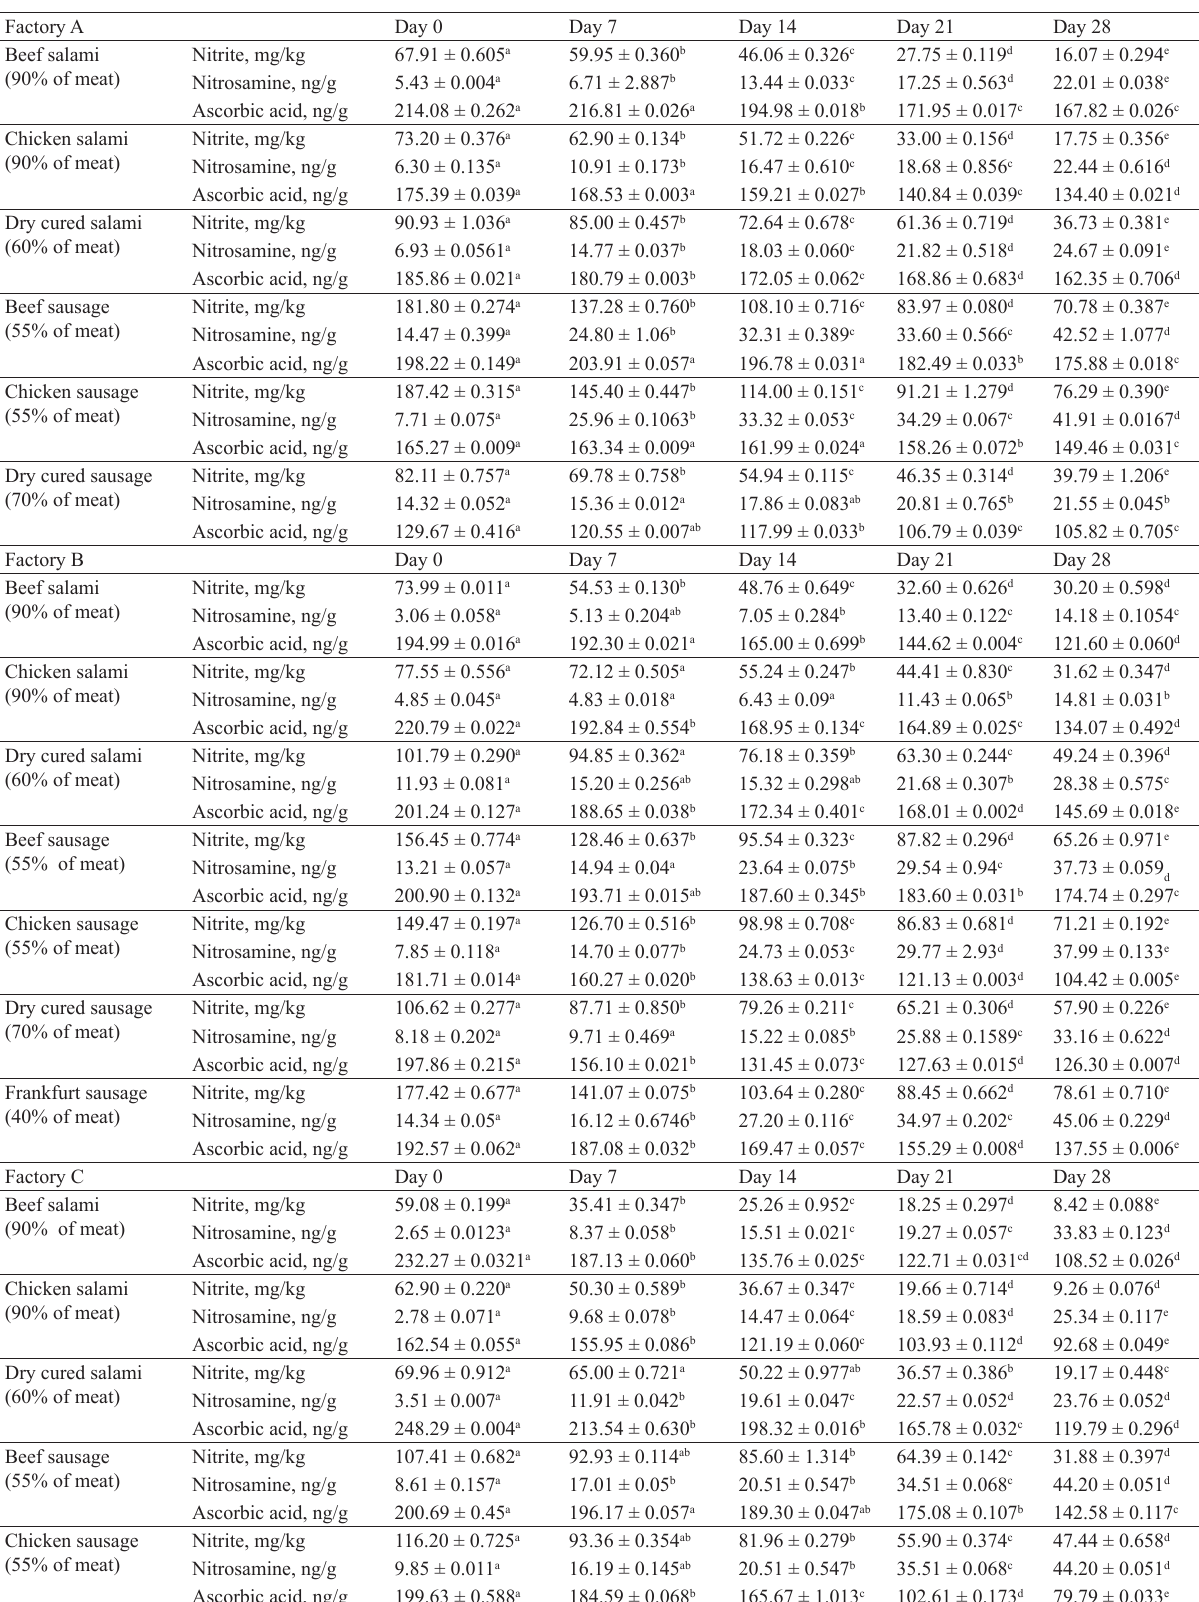
Table 1. Residual nitrite, ascorbic acid and nitrosamine contents in sausages produced by four major meat factories during